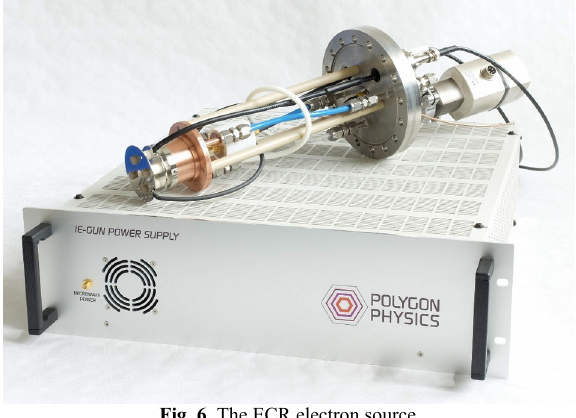
Fig. 6. The ECR electron source